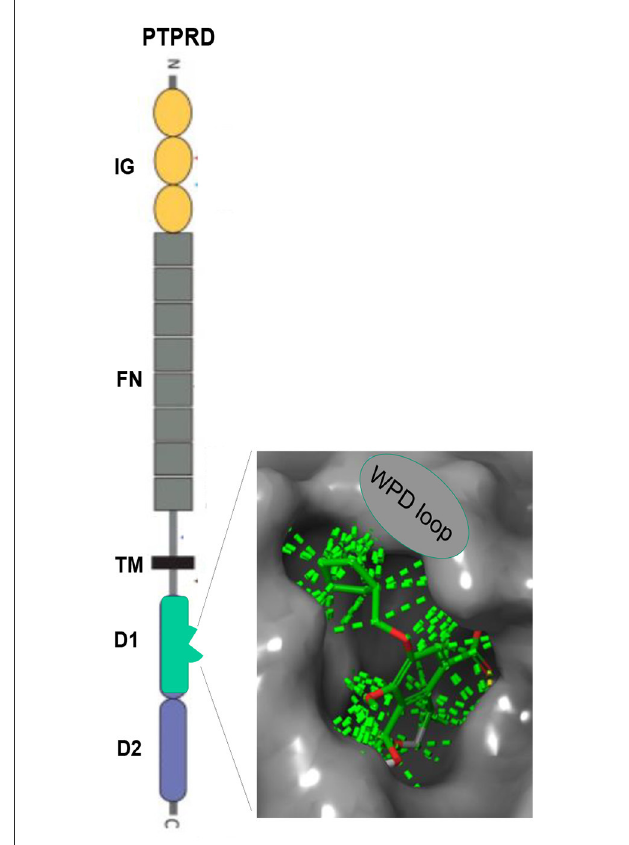
FIGURE1 PTPRD. Extracellular immunoglobulin (IG) and fibronectin (FN) domains, transmembrane (TM) domain, D1 intracellular phosphatase domain. Enlargement: Pentilludin (NHB1109) bound to PTPRD phosphatase catalytic site and WPD loop. Dashed lines: van der Walls interactions.